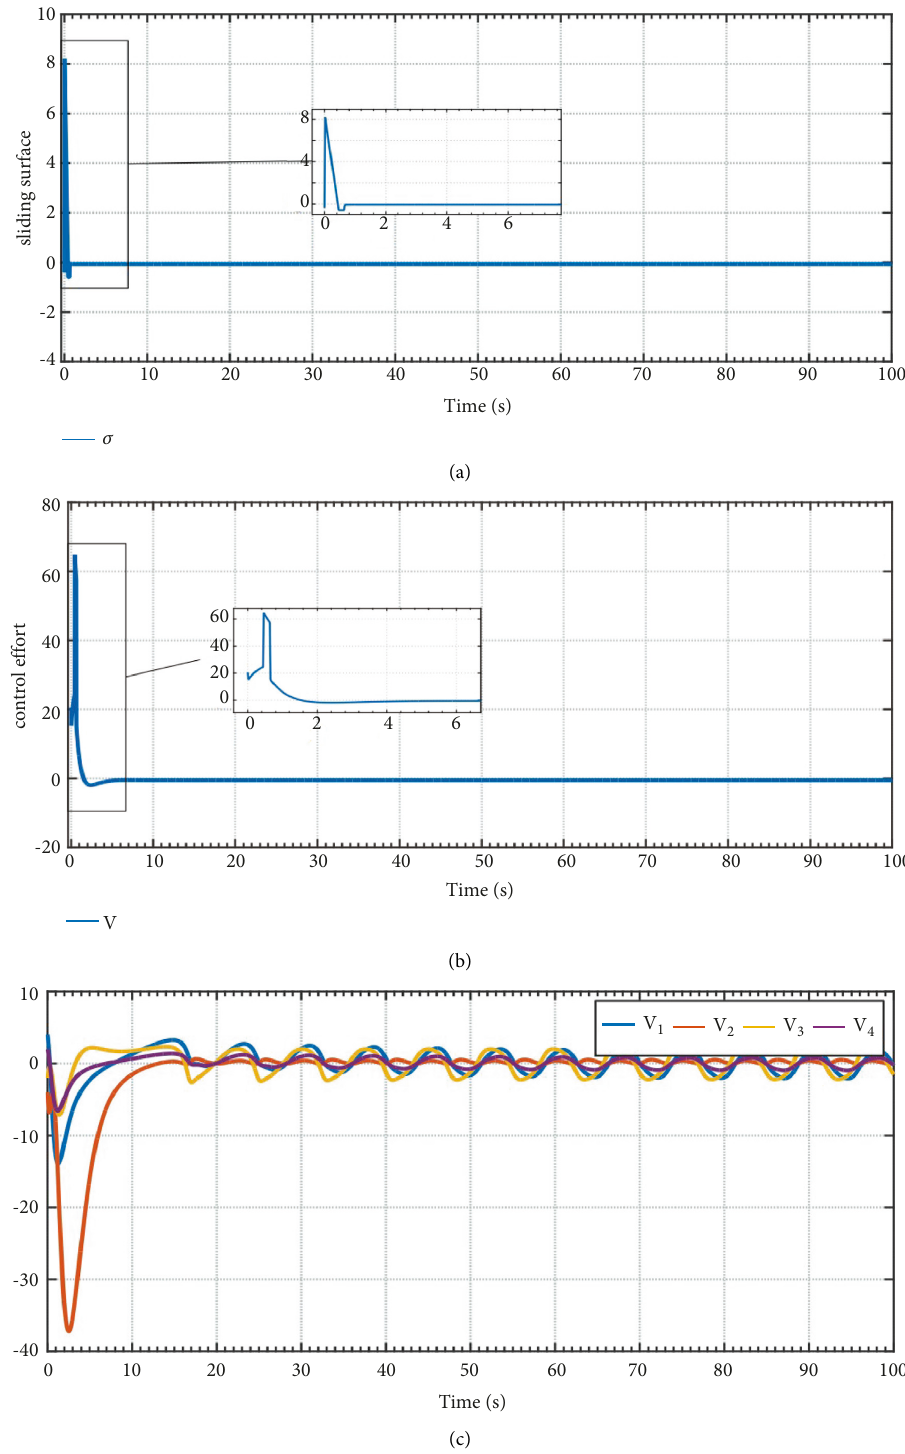
Figure 4: Antisynchronization of identical 4D hyperchaotic financial system. (a) Sliding manifold σ . (b) Control effort v . (c) v represent the time-varying